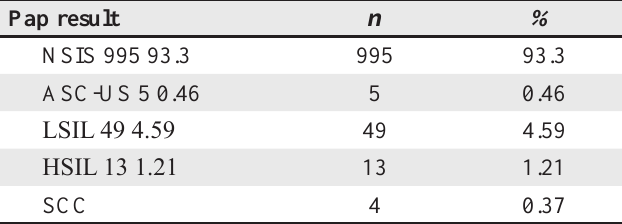
Table 1 : Different categories of diagnosis in Pap smear (N=1066)